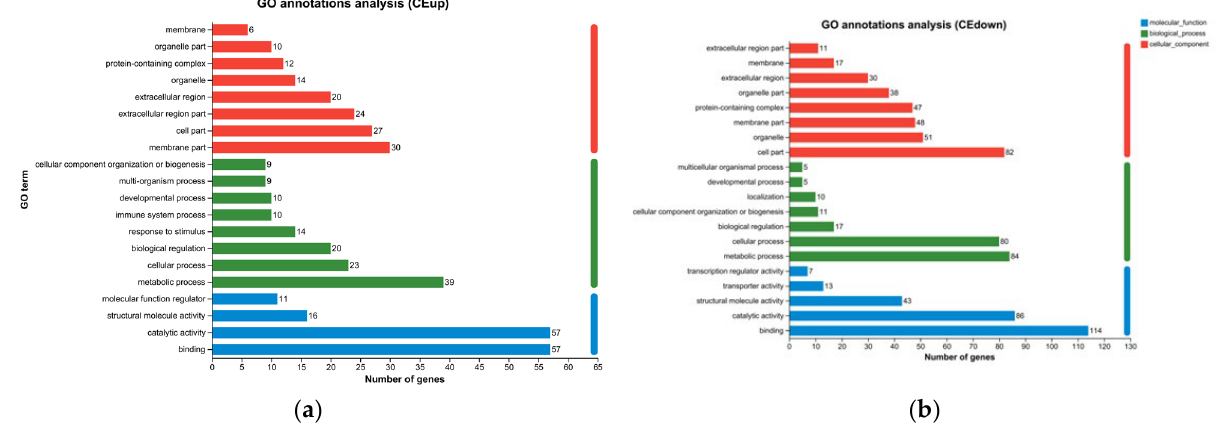
Figure 2. GO classification of functional pathways (( a ) up-regulated genes; ( b ) down-regulationgenes).